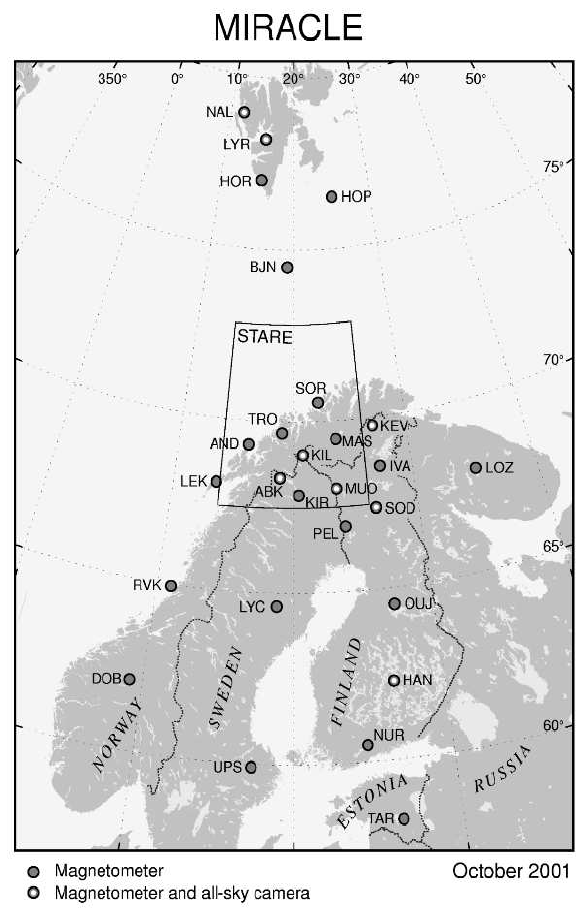
Fig. 1. Map of the MIRACLE